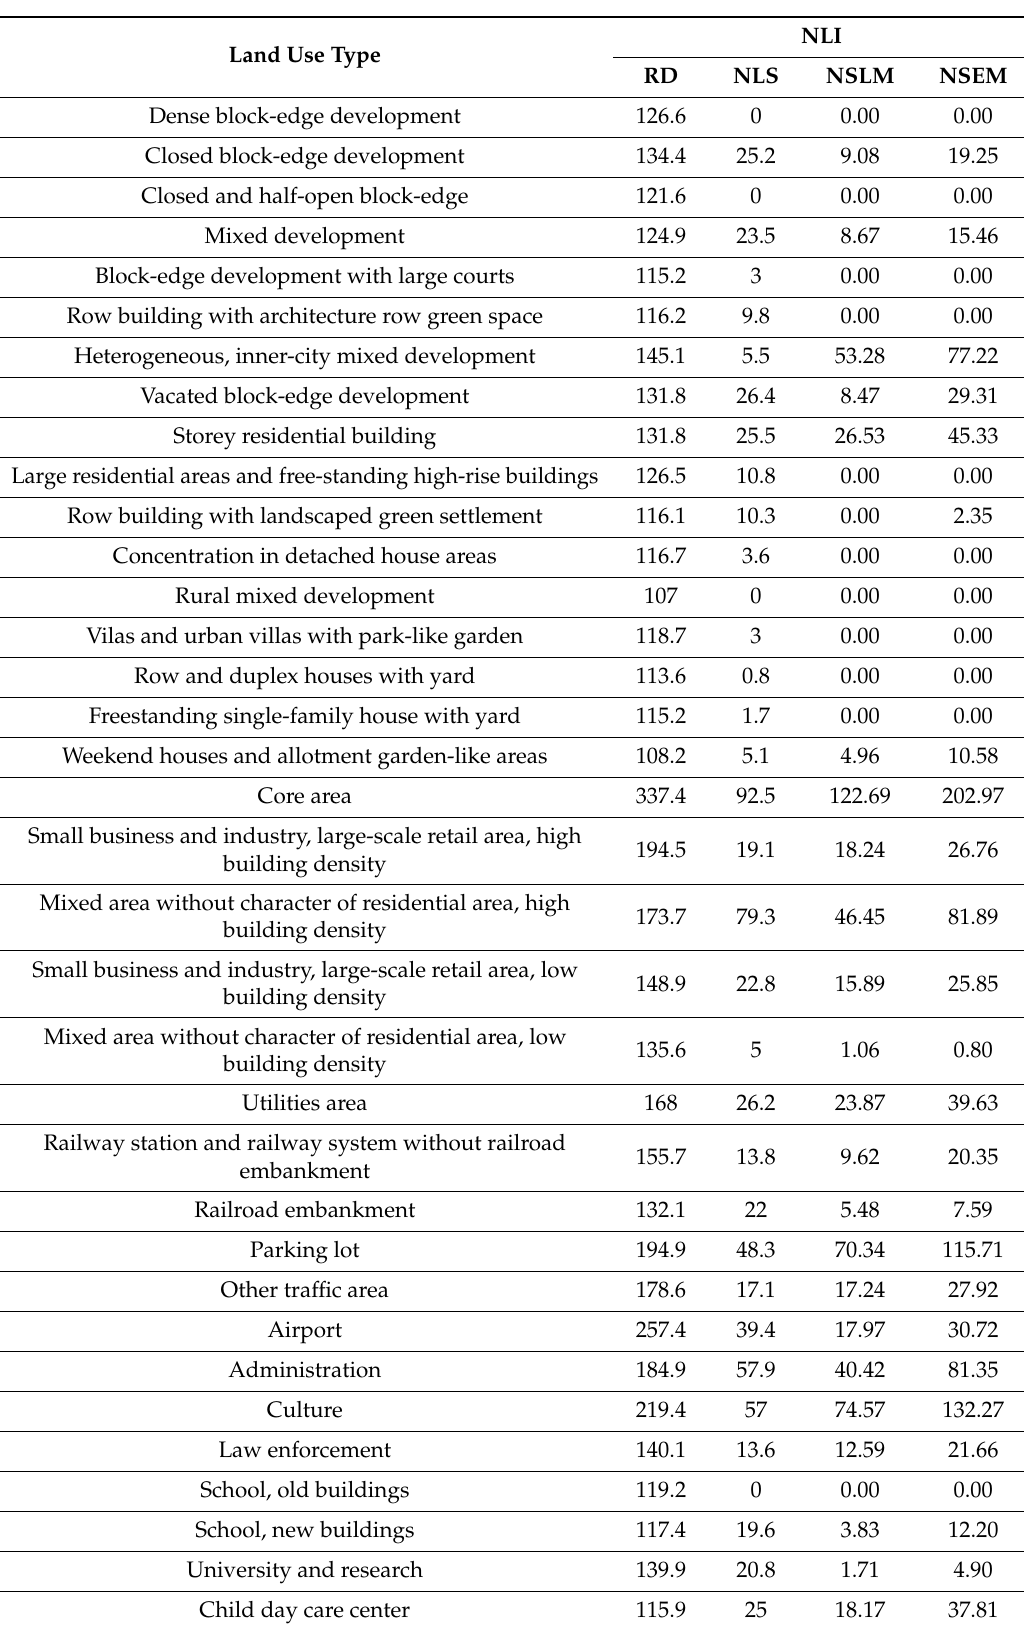
Table A3. NLIs of reference data and analysis data from di ff erent models in